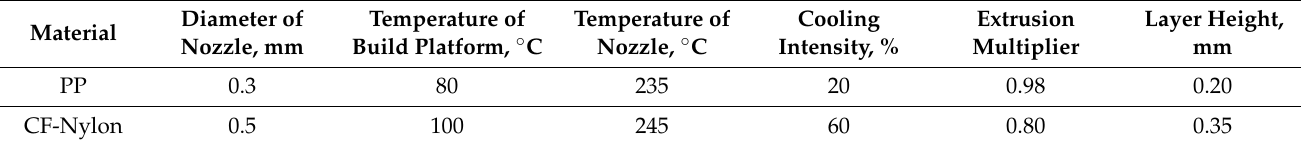
Table 5. Parameters of FFF process.